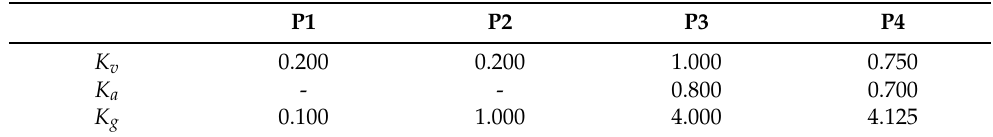
Table 7. Parameter setting for CACC